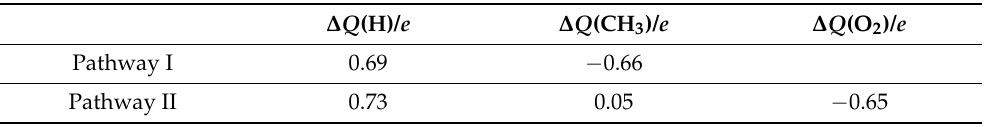
Figure 3. The partial density of states analysis of initial, transition state, and final structures on pathway I and II. “*” indicated the surface adsorbed spices. Table 1. Bader charge analysis of key species during the C-H bond breaking. H and CH 3 represented the dissociated fragments from methane activation.